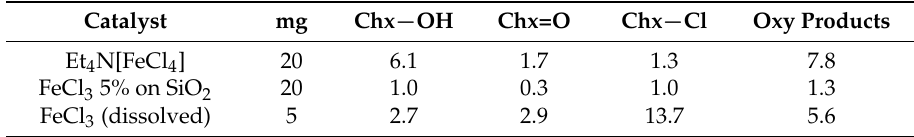
Table 7. Products formed ( µ mol) during the photolysis (100 W Hg lamp, λ > 360 nm, 50% O 2 /50% air balloon, 20 min irradiation) of 1.0 mL of cyclohexane (1% acetic acid) with FeCl 3 and Et 4 N[FeCl 4 ] as